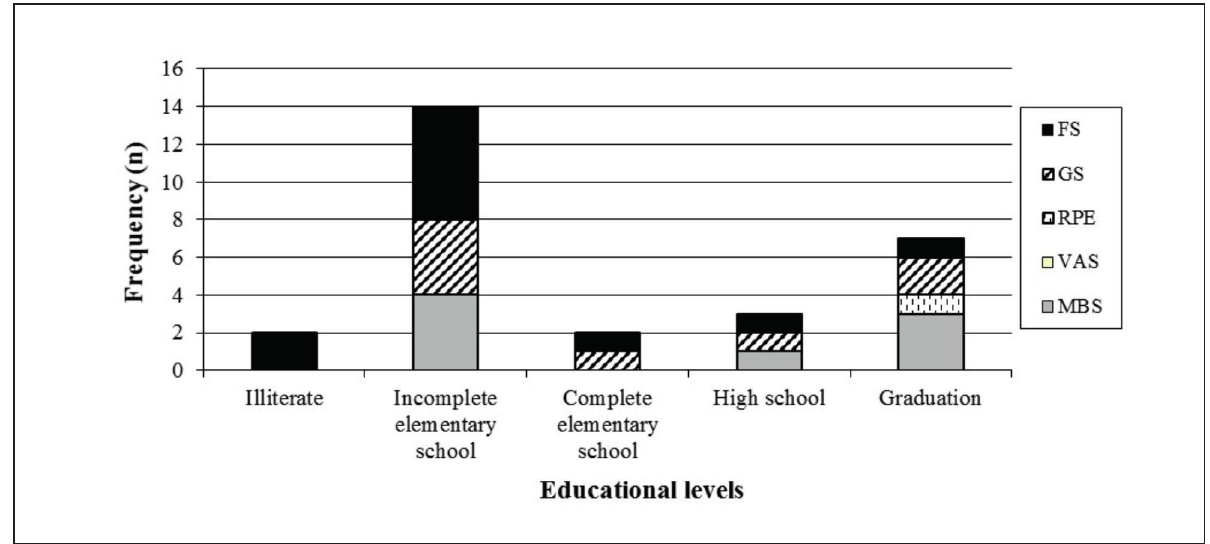
Figure 1 - Educational levels x Preference for the